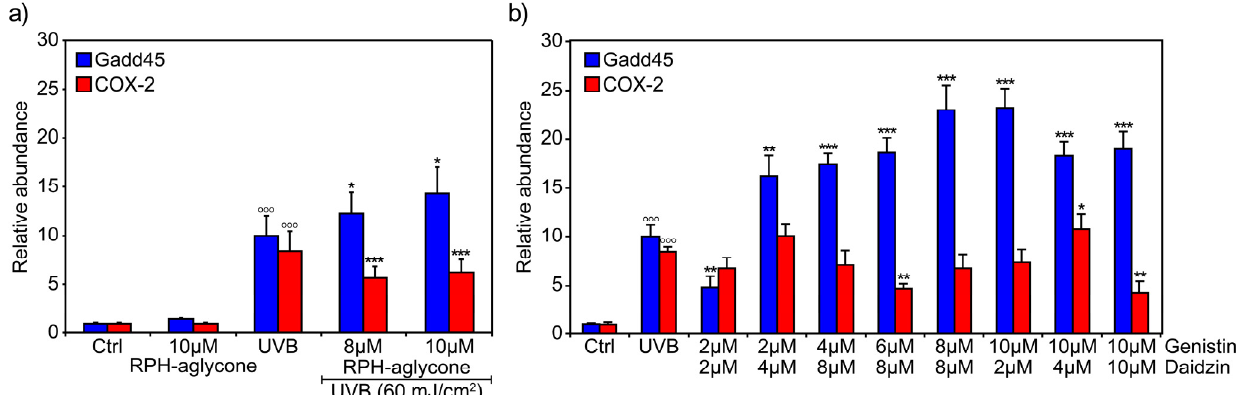
Figure 4. Effects of genistin and daidzin combinations and RPH-aglycone on the levels of Gadd45 and COX-2 mRNA in BJ-5ta cells irradiated with 60 mJ/cm 2 UVB. Levels of Gadd45 and COX-2 mRNA were determined by real-time PCR using a total RNA preparation from BJ-5ta cells treated for 2 h with the most effective concentrations of ( a ) RPH-aglycone (8 µM to 10 µM) ( a ) or ( b ) with different combinations of genistin (from 2 µM to 10 µM) and daidzin (from 2 µM to 10 µM). The cells were harvested 24 h after 60 mJ/cm 2 of UVB irradiation. The bars indicate the relative abundance of each mRNA; +1 is the abundance of Gadd45 and COX-2 mRNA in the unirradiated and untreated cells. All values represent the mean ± SD of triplicate experiments. * p < 0.05, ** p < 0.001, *** p < 0.0001, ◦◦◦ p < 0.0001 (Ctrl: untreated and unirradiated control cells; UVB: untreated and irradiated (60 mJ/cm 2 )